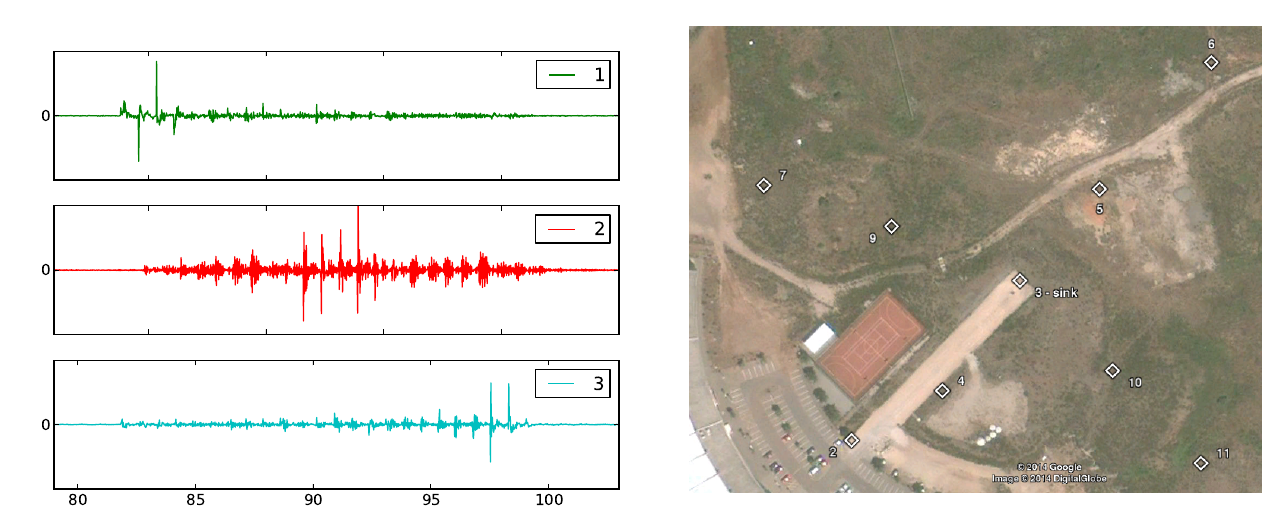
Figure 23. Location of the nine deployed Fig. 23: Location of the 9 deployed nodes